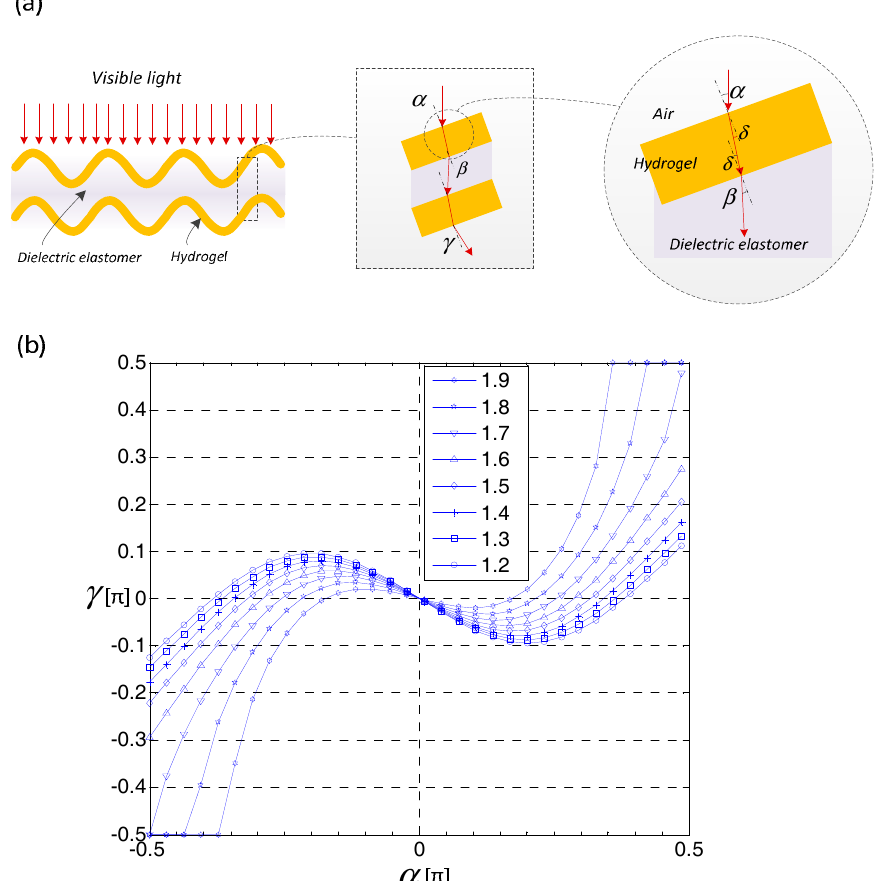
Figure 10. Optical transmission analysis. ( a ) The refraction optical path through the wrinkled hydrogel. ( b ) Calculation of optical excite incident angle.